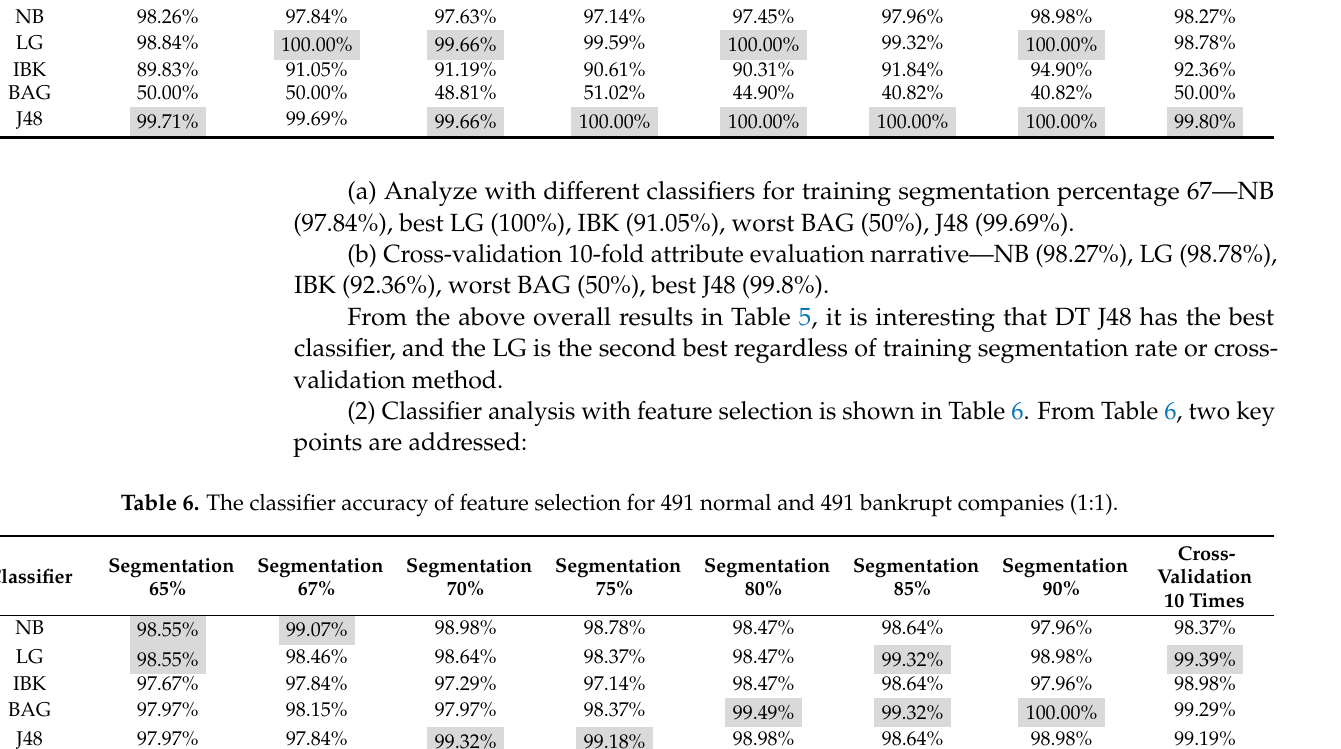
Table 5. The classifier accuracy of no-feature selection for 491 normal and 491 bankrupt companies (1:1). Classifier